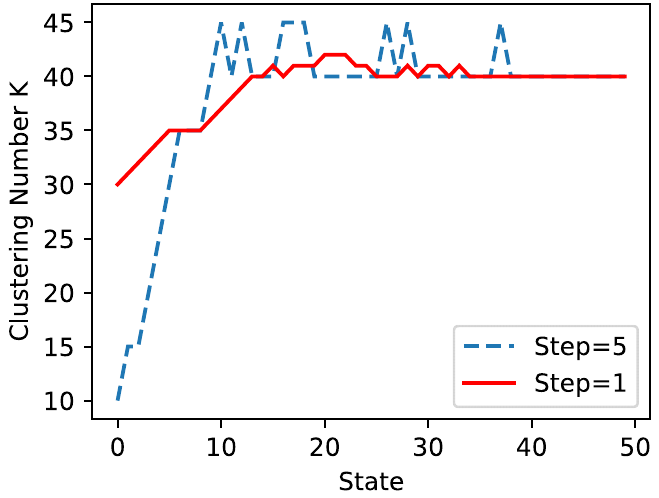
Figure 8. The path of searching for the optimal clustering number K.